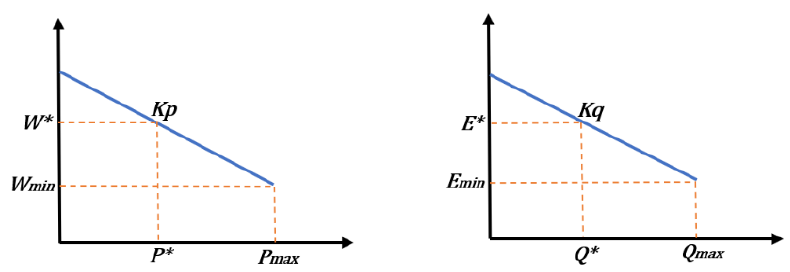
Figure 4. Conventional droop control characteristics.